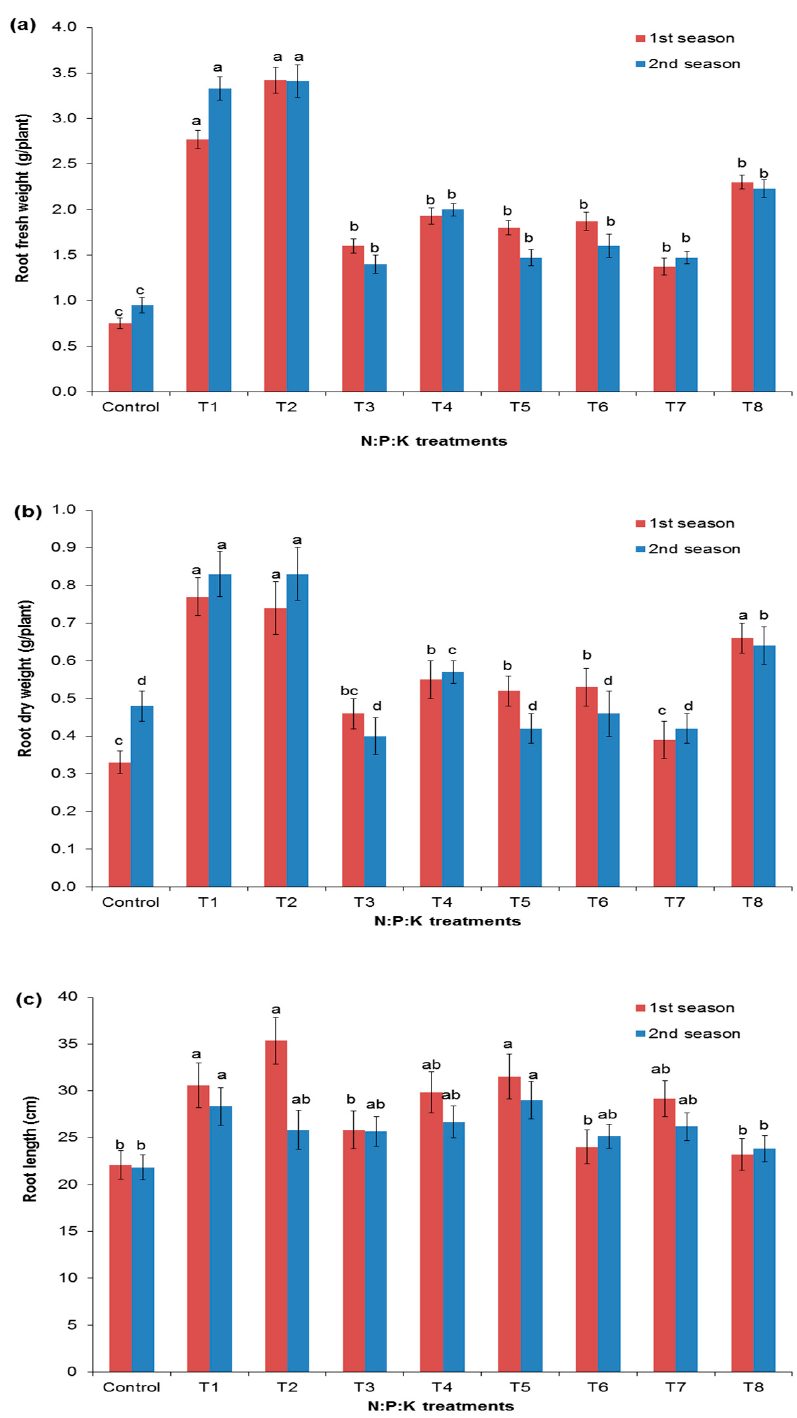
Figure 3. Effect of NPK doses on the root fresh weights ( a ), the root dry weights ( b ), and the root lengths ( c ) of Salvadora persica . Dissimilar letters designate the significance among means ( p < 0.05) using Duncan’s multiple range test (means ± standard errors ( n = 5)) for the different fertilization